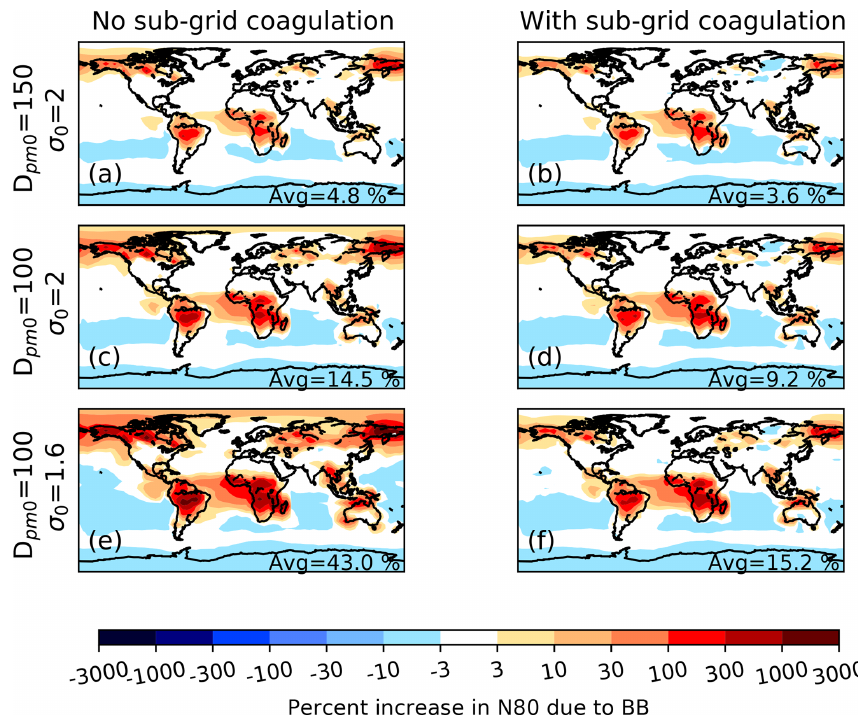
Figure 4. Annual-average percent changes in N80 at the surface level due to the inclusion of GFED biomass burning emissions relative to the simulation without biomass burning ( noBB ). Panels (a) , (c) , and (e) have no sub-grid coagulation ( D150_noSubCoag , noSubCoag , and s1.6_noSubCoag , respectively). Panels (b) , (d) , and (f) have sub-grid coagulation ( D150_SubCoag , SubCoag , and s1.6_SubCoag , respec- tively). Panels (a) and (b) have an emitted median diameter of 150nm and an emitted modal width of 2. Panels (c) and (d) have an emitted median diameter of 100nm and an emitted modal width of 2. Panels (e) and (f) have an emitted median diameter of 100nm and an emitted modal width of 1.6. The number in the bottom right of each panel is the global mean percent increase in N80 due to biomass